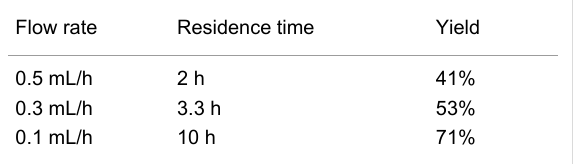
Table 2: Yield comparison at different flow